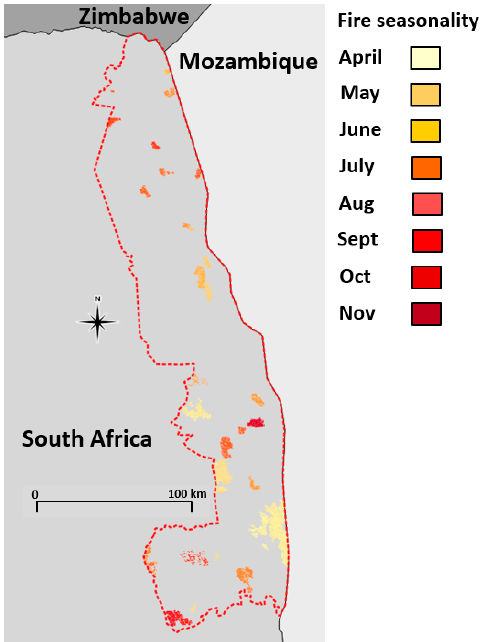
Figure 3. MODIS 500-m burned areas detected in the Kruger National Park (red dashed line) in 2015. The burns are colored to show their approximate seasonality.